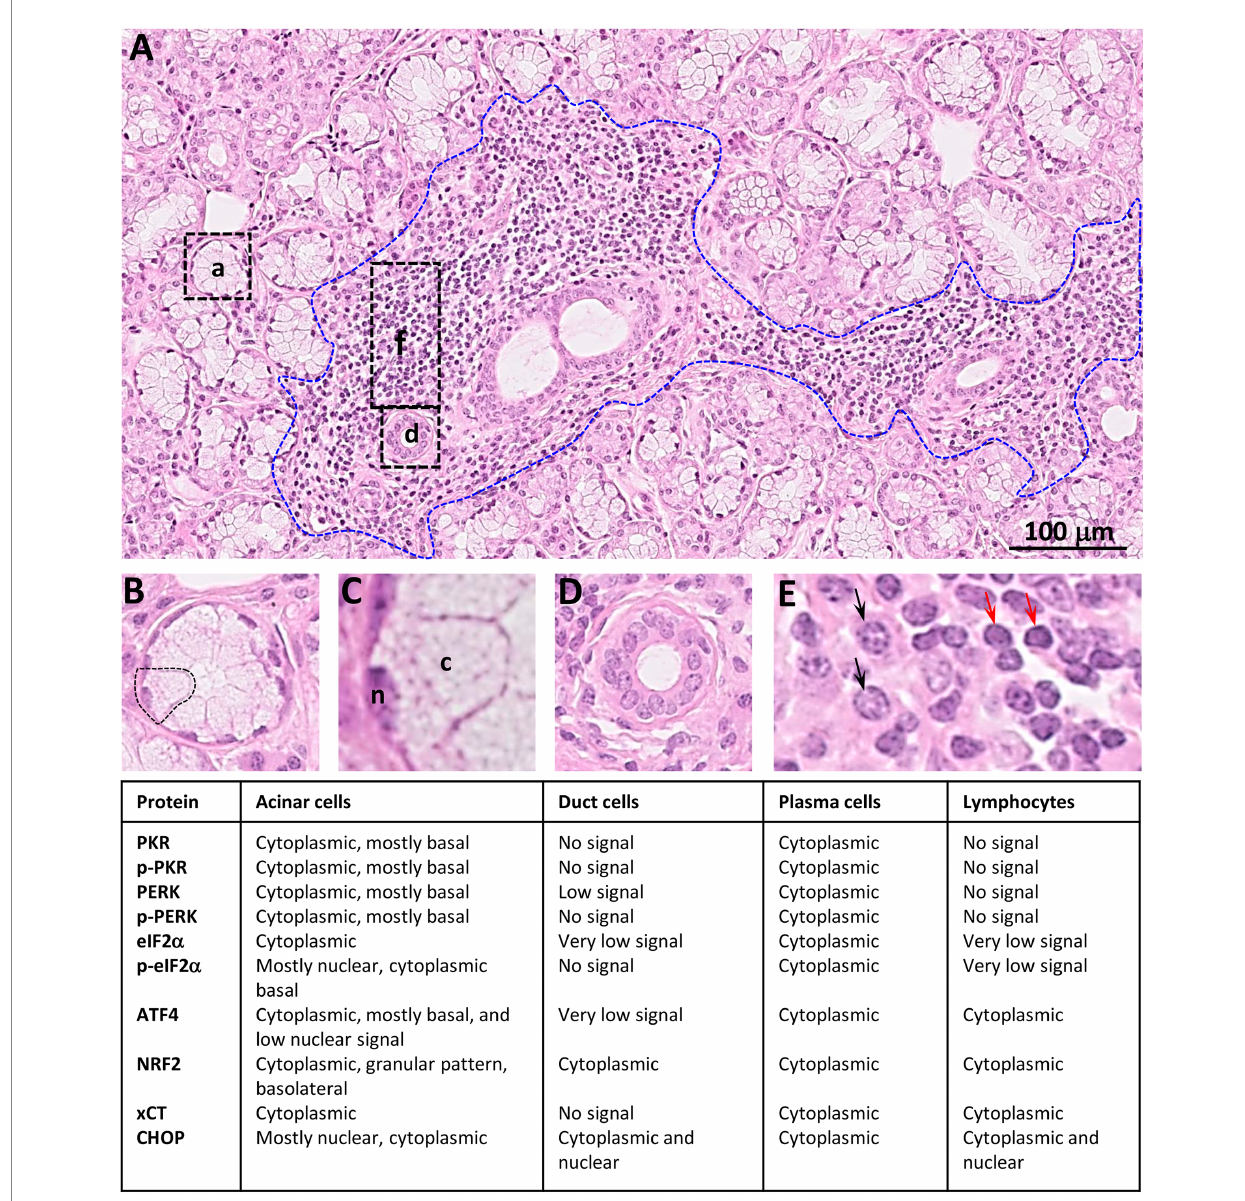
FIGURE 16 Summary of distribution observed for ISR proteins in LSGs from SS-patients. (A) Histology of a LSG from a representative SS-patient showing several acini (a), few ducts (d), and a lymphoplasmacytic focus (f, bounded by blue broken line). Bar: 100 μ m. (B) Higher magnifications of an acini. (C) Higher magnifications of an acinar cell, n: nuclei; c: cytoplasm. (D) Higher magnification of a duct. (E) Higher magnification of inflammatory cells showing plasma cells (black arrows) and lymphocytes (red